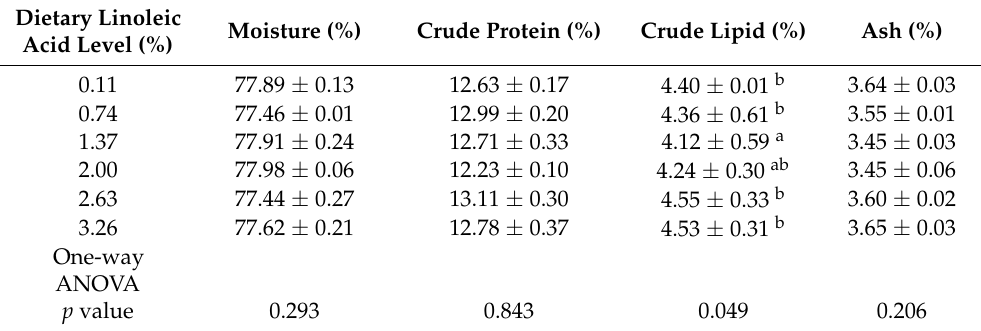
Table 4. Whole-body proximate composition of coho salmon Oncorhynchus kisutch alevins fed with experimental diets with different dietary LA levels for 12 weeks (means ± SE, n = 3). Dietary Linoleic Moisture (%) Acid Level (%)